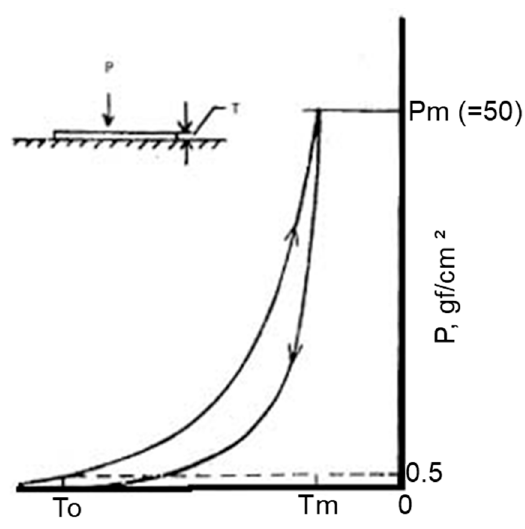
Figure16. Compressional property Figure 16. Compressional property